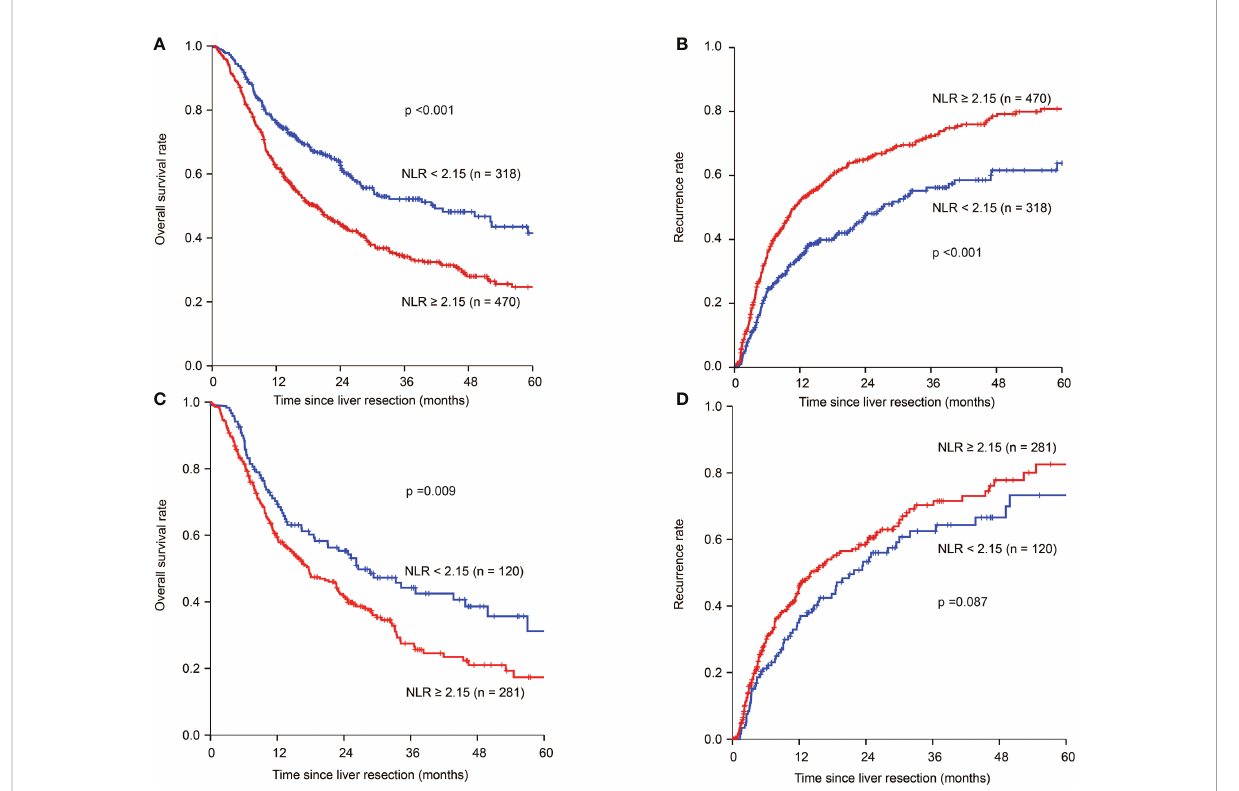
FIGURE 2 Kaplan – Meier estimate of OS and tumour recurrence for NLR high and NLR low ICC patients in the HBV infection group and no-HBV infection group. (A) Kaplan-Meier estimate of OS for NLR high and NLR low group in the HBV infection group. (B) Kaplan-Meier estimate of tumour recurrence for NLR high and NLR low group in the HBV infection group. (C) Kaplan-Meier estimate of OS for NLR high and NLR low group in the no-HBV infection group. (D) Kaplan-Meier estimate of tumour recurrence for NLR high and NLR low group in the no-HBV infection group.